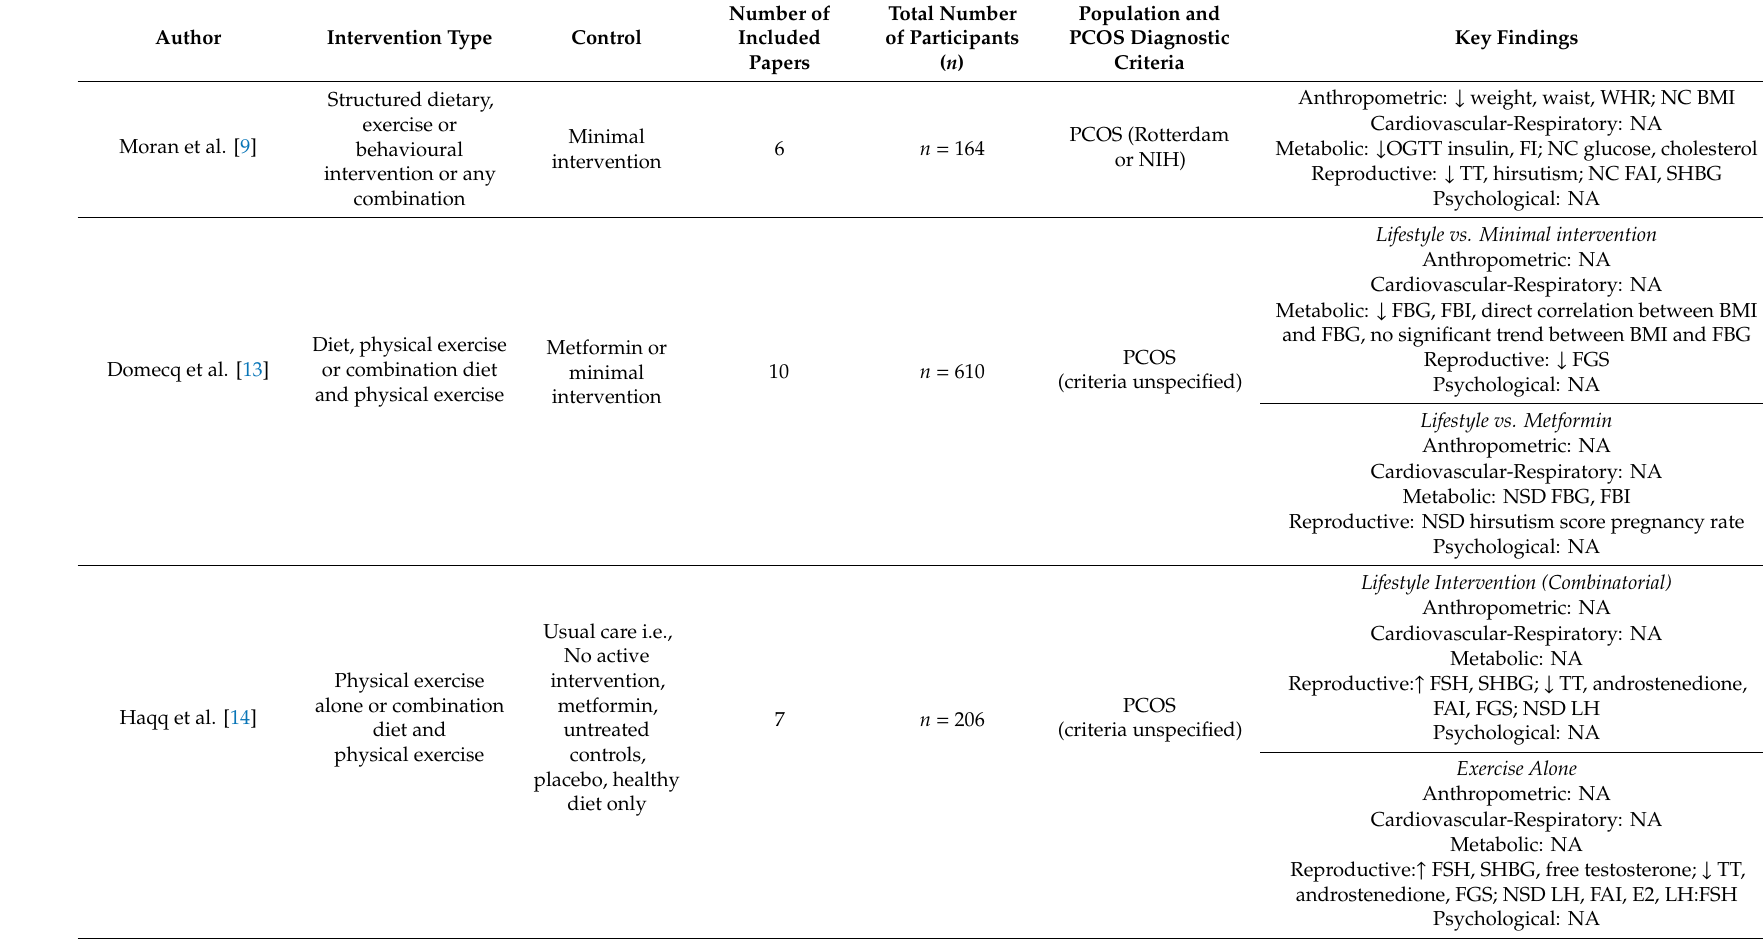
Table 1. A summary of current evidence from meta-analyses on lifestyle management in